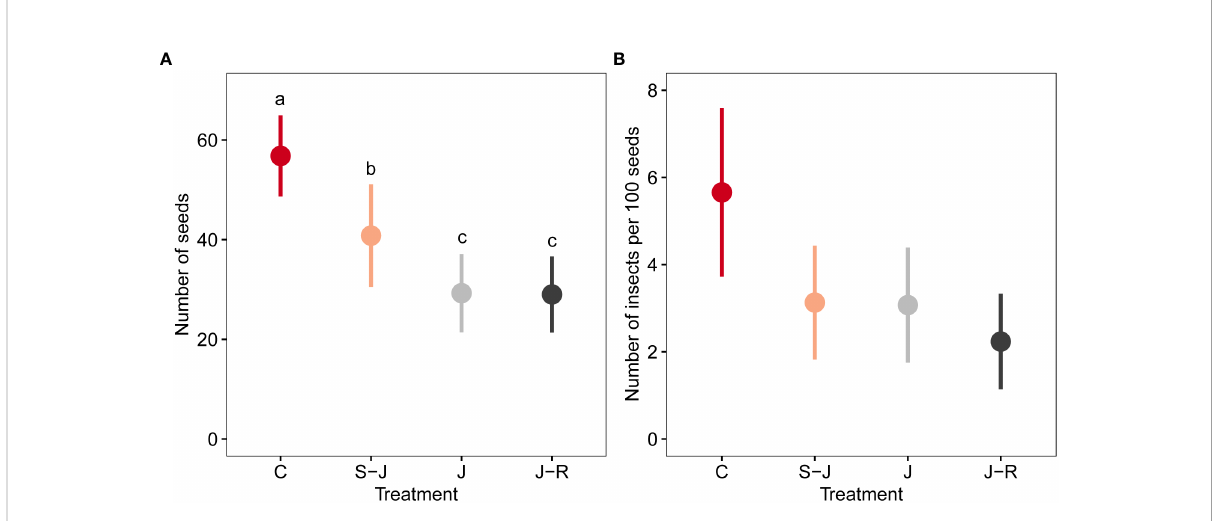
FIGURE 3 Effects of timing and frequency of damage on seed production and interactions with seed insects. (A) number of seeds as a measure of reproductive output and (B) number of seed insects per 100 seeds per plant. The number of insects includes seed beetles and parasitoids, thus indicating the initial infestation by seed beetles. Treatment groups were: mechanically undamaged control plants (C); plants damaged at the seedling and juvenile stage (S-J), only at the juvenile stage or at the juvenile stage and reproductive stage (J-R). Different letters indicate signi fi cant differences among damage